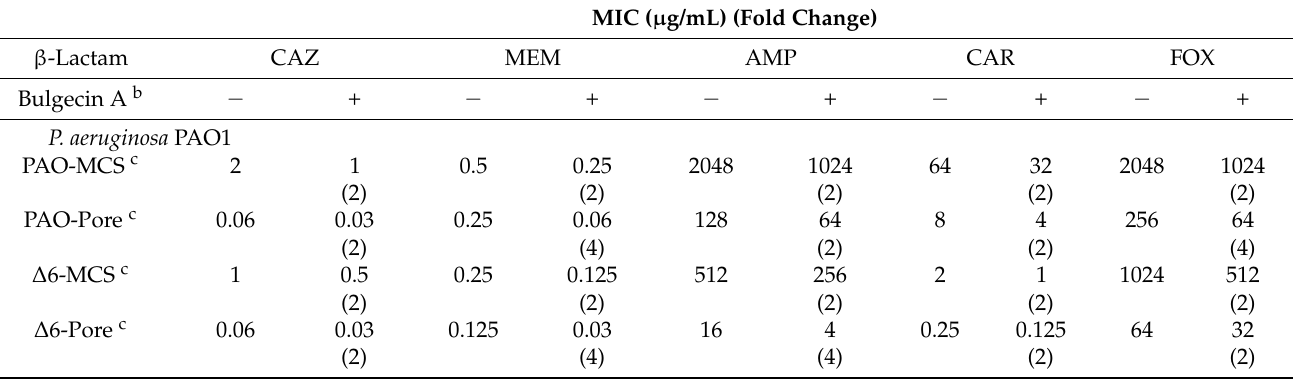
Table 3. Effect of bulgecin A on the MIC of β -lactams against the strains overexpressing a channel protein FhuA a . MIC ( µ g/mL) (Fold